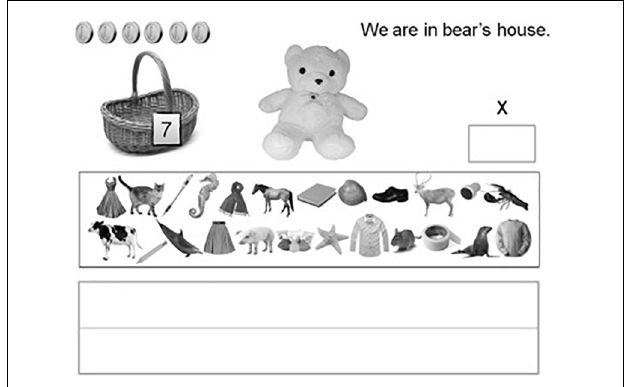
FIGURE 1 | Initial set-up in bear’s